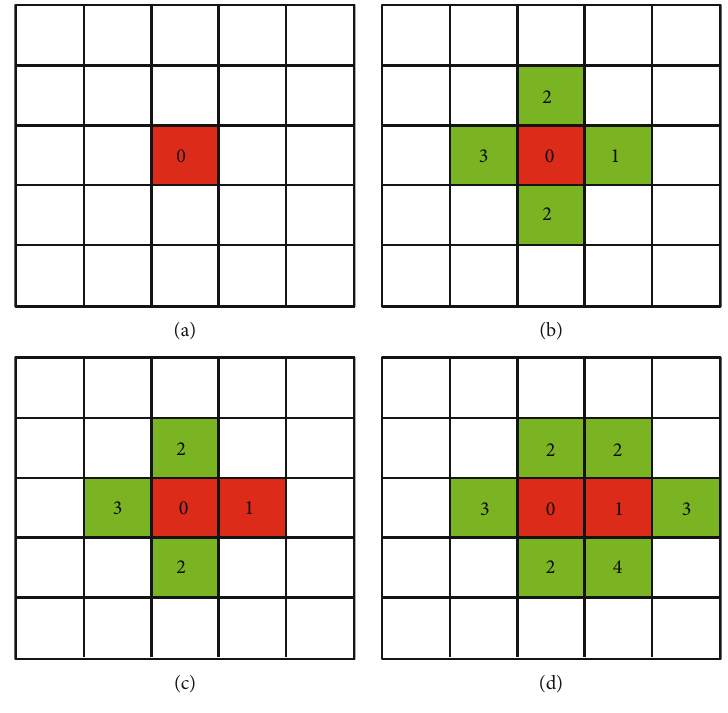
Figure 19: Calculating process of